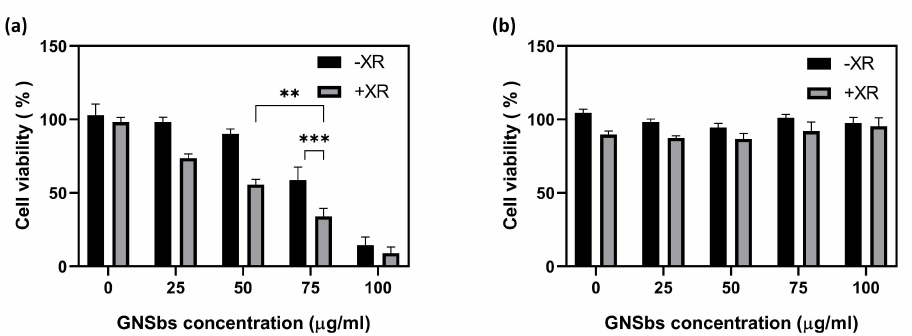
Figure 4. The cytotoxicity of ( a ) CAL-27 and ( b ) L929 cells treated with or without the GNSbs under radiation. The cytotoxicity of CAL-27 cells treated with or without the GNSbs (0, 25, 50, 75, and 100 µ g mL − 1 ) under radiation (0 and 2 Gy) at 48 h ( n = 3, ** p < 0.01 and *** p <